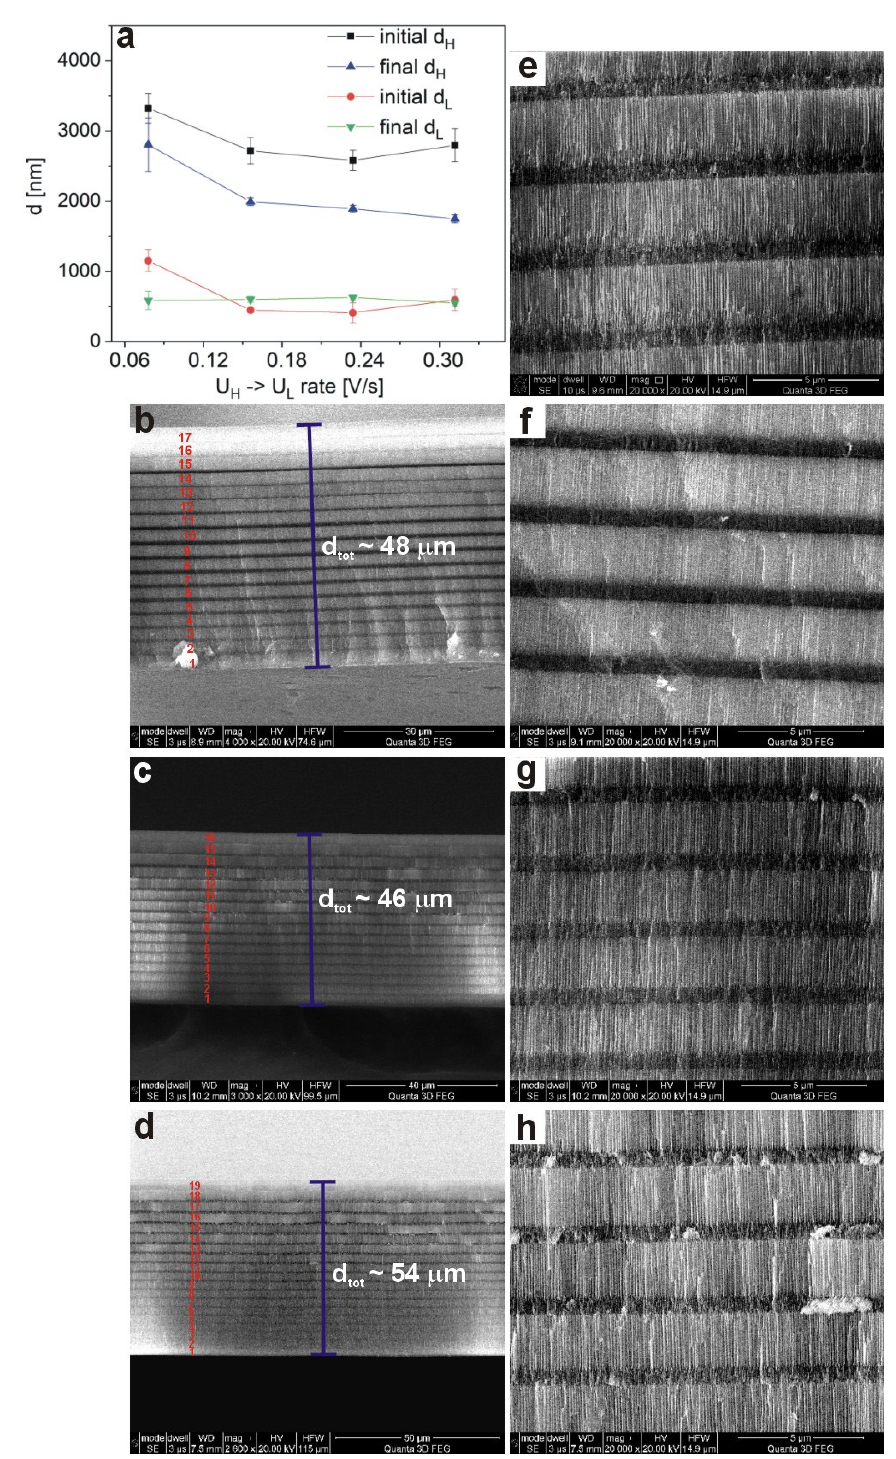
Figure 8. Thickness of d H and d L segments as a function of the U H ̶˃ U L drop rate ( a ); SEM images of a cross-sectional view of the whole PAA—30 °C_0.156 ( b ), PAA—30 °C_0.234 ( c ), and PAA—30 °C_0.312 ( d ) membrane; SEM images of middle d H and d L layers of the PAA—30 °C DBRs with U H ̶˃ U L rate of 0.078 V/s ( e ), 0.156 V/s ( f ), 0.234 V/s ( g ), and 0.312 V/s ( h ).